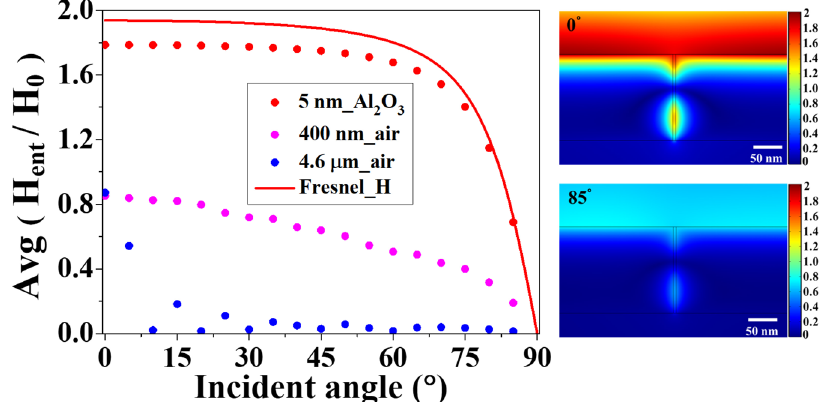
Figure 3. Magnetic field amplitude at the gap entrance versus the incident angle for the 5-nm (red circles), 400-nm (magenta circles) and 4.6- μ m (blue circles) gaps. Magnetic field given by the Fresnel equations is shown as the red solid line for comparison. Magnetic field distributions in the vicinity of the 5-nm gap for 0° and 85° incident angles are shown at the right panels. The two cases are the same except for the